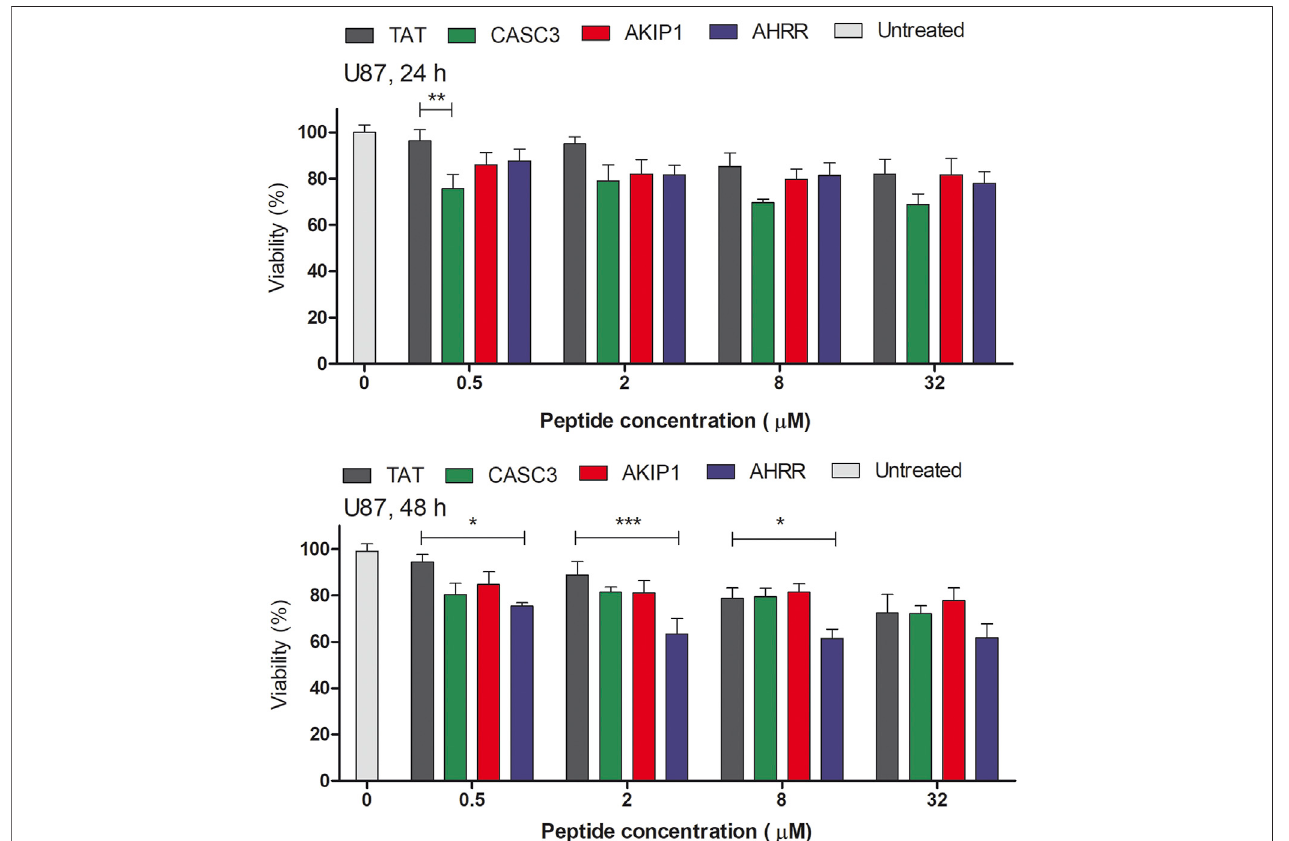
FIGURE 3 | MTS assay on the U87 cells in serum free media. The absorbance was measured at 24 and 48 h time points after the addition of the peptides to the cells. The tested peptides ’ range was between 0 and 32 µM. The results from the absorbance measurement are normalized to the untreated cells (100%). Two-way ANOVA with Bonferroni post-test was used for the statistical analysis of the treatment groups to control CPP Tat treated group at the same concentration. ns (not marked) indicates p > 0.05; * indicates p < 0.05; ** indicates p < 0.01; *** indicates p < 0.001.